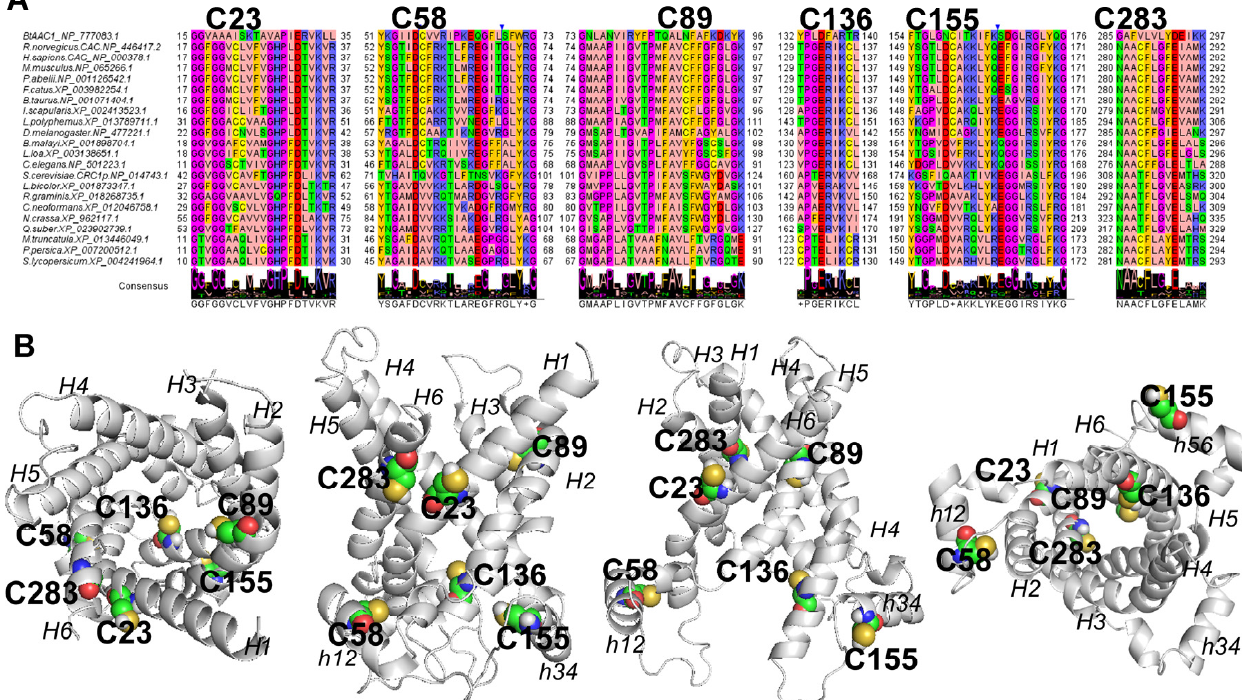
Figure 5. Multiple sequence alignment and 3D comparative modelling of CAC. An extract of the multiple sequence alignment of CAC protein closest homologs, sampled by BlastP, through Mammalia, Arthropoda, Nematoda, Fungi and Plants is reported in panel ( A ). The reported CAC protein fragments host the investigated cysteine residues. The proposed alignment was obtained by using the zappo colour style of Jalview. Bold labels indicate the location of the cysteine residues, investigated by site-directed mutagenesis and transport assays in this work. In panel ( B ), the 3D comparative models of CAC protein in c-conformation (starting from the left, top view and lateral view) and m-conformation (lateral view and bottom view) are reported in a grey cartoon. Cysteine residues are reported in spheres representation and labelled for comparative purposes. The transmembrane helices H1-H6 parallel to the membrane plane and the short helices, h12, h34, and h56 are indicated by italics